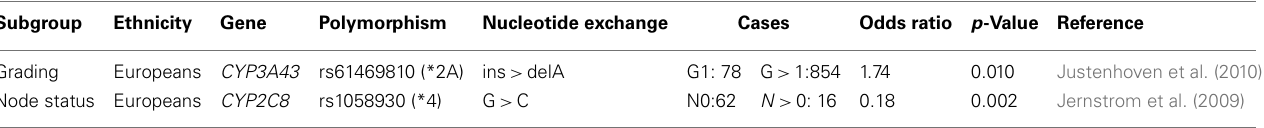
Table 2 | Polymorphisms in phase I and II enzymes associated with histo-pathological characteristics of breast tumor. Subgroup Ethnicity Gene Polymorphism Nucleotide exchange Cases Odds ratio p -Value